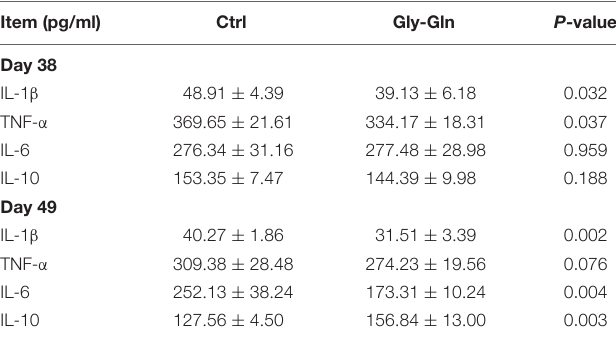
TABLE 3 | The concentration of serum cytokines in the